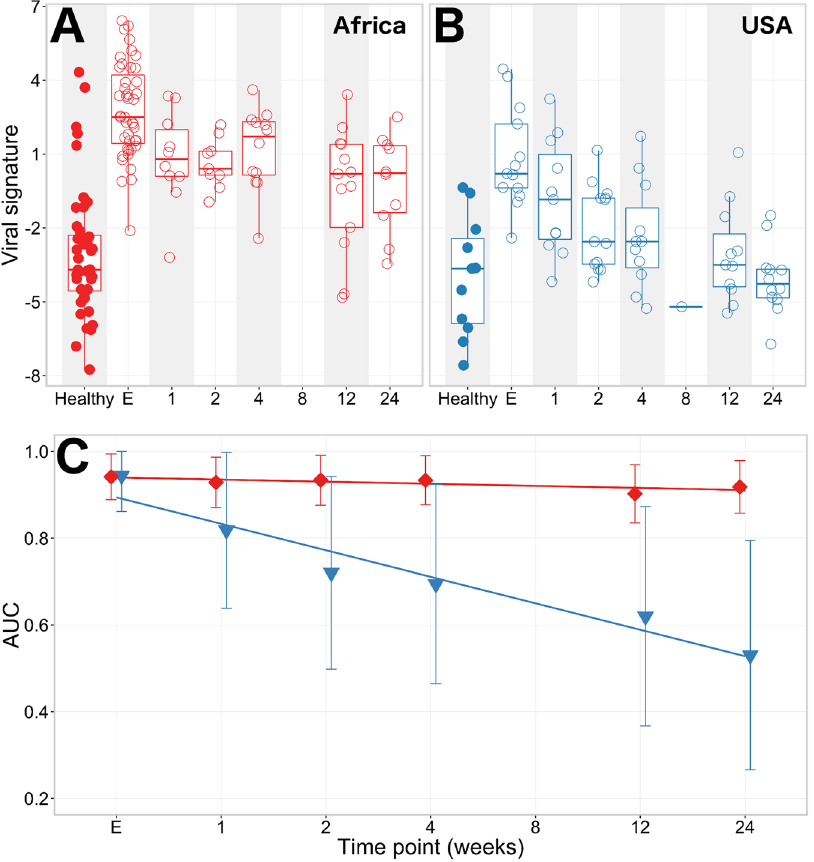
Figure 5. Pan-viral signature AUCs for patients with acute HIV-1 infection compared to matched uninfected healthy subjects (GEO dataset GSE29429). Panel (A): Pan-viral signature score for healthy African controls (solid points) versus HIV-1 -positive untreated African subjects (open points). Panel (B): Pan-viral signature score for healthy American controls (solid points) versus HIV-1 -positive ART-treated American subjects (open points). Panel (C): When untreated African patients were compared to the corresponding healthy African controls, the pan-viral signature AUC ( ± 95% CI) remained at or above 0.9 for all timepoints (red diamonds). In contrast, when American patients receiving ART-treatment were compared to the corresponding American controls, the pan-viral signature AUC dropped from above 0.9 at enrolment to less than 0.5 by week 24 (blue triangles). Abbreviations: ROC, receiver operating characteristic curve; ART, anti-retroviral therapy; AUC, area under